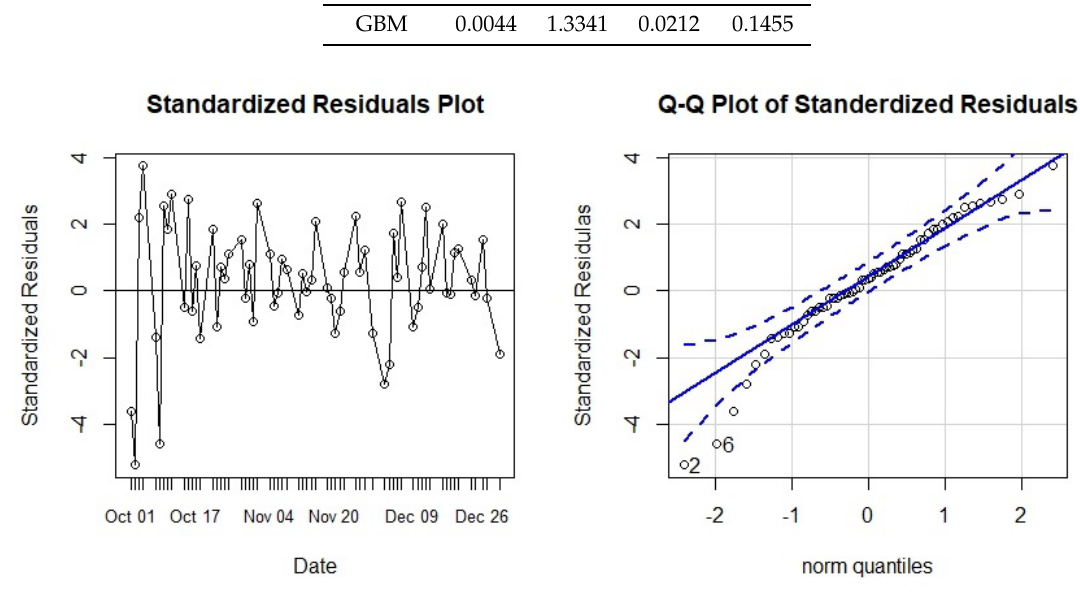
Figure 9. GBM model diagnostics.